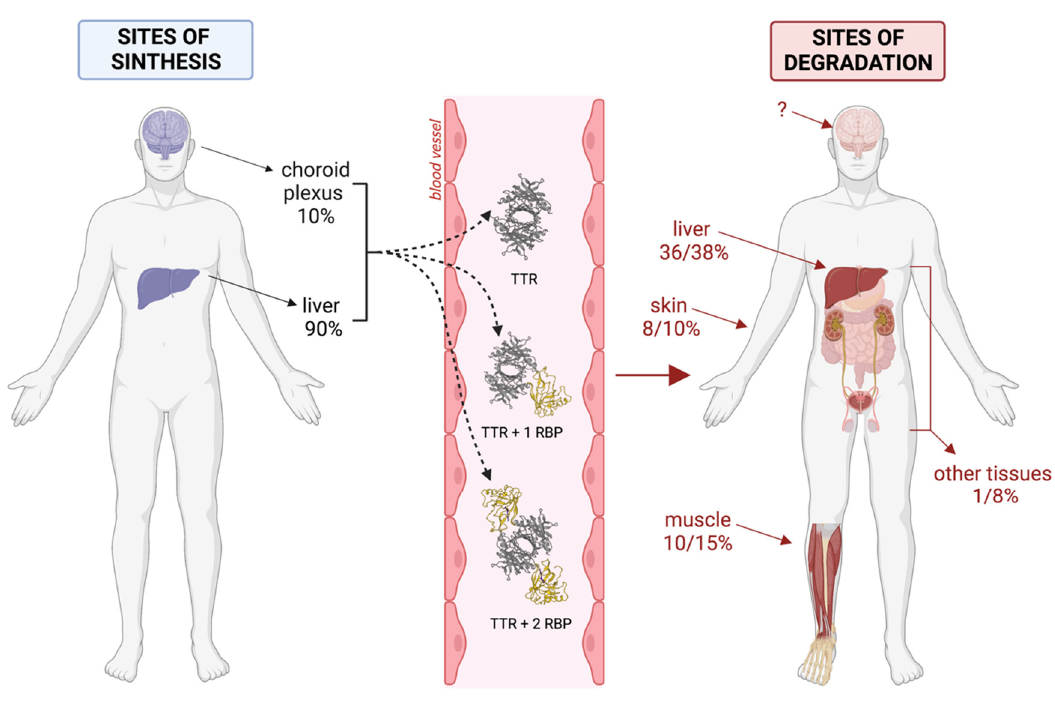
Figure 6. Reconstruction of the possible life cycle of TTR. The figure was created through “biorender.com” web site (license agreement number DL2489YBZI), access date 22/06/2022..